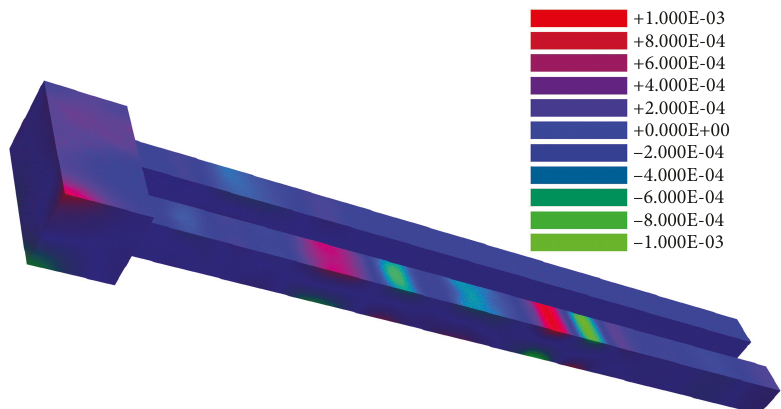
Figure 7: EFIT model (time t